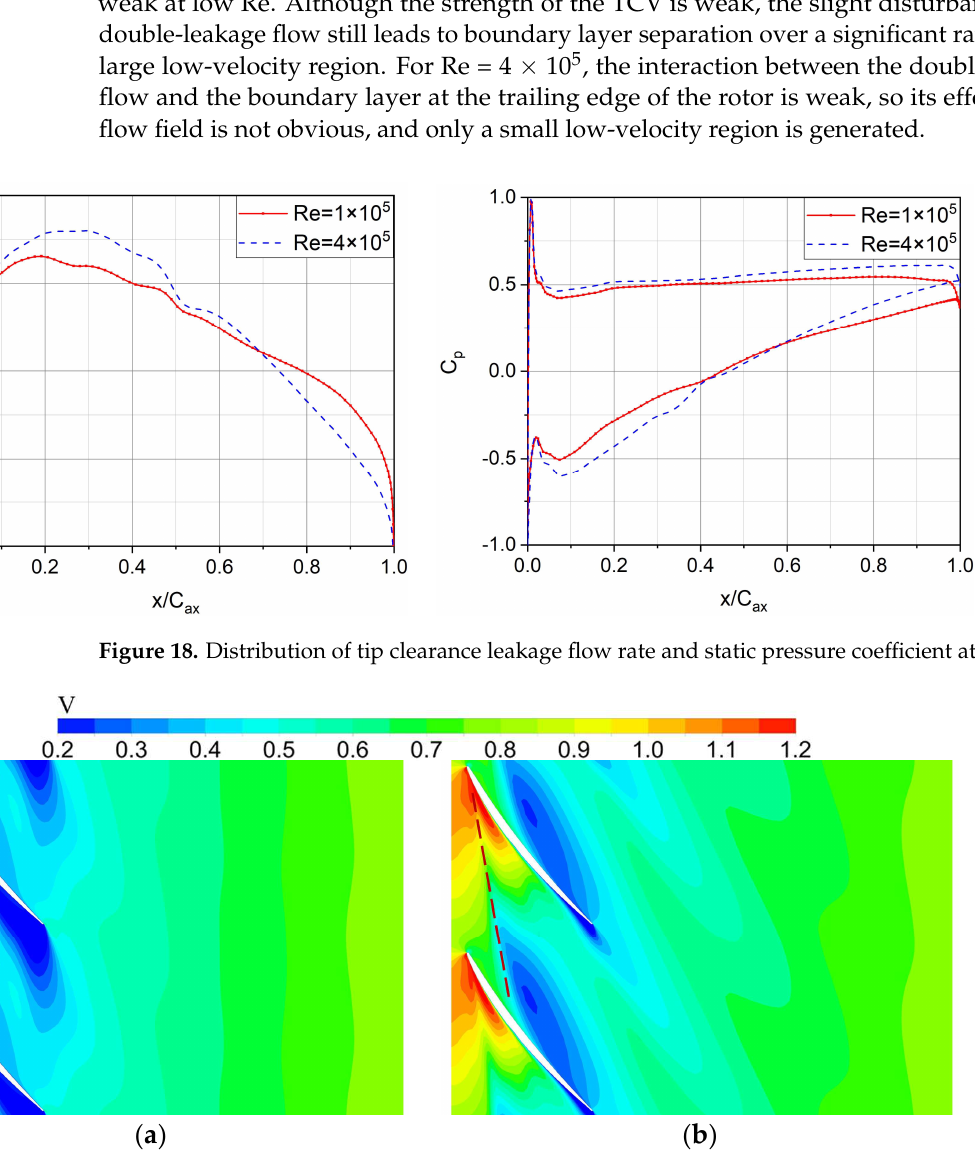
Figure 18. Distribution of tip clearance leakage flow rate and static pressure coefficient at 99% span.